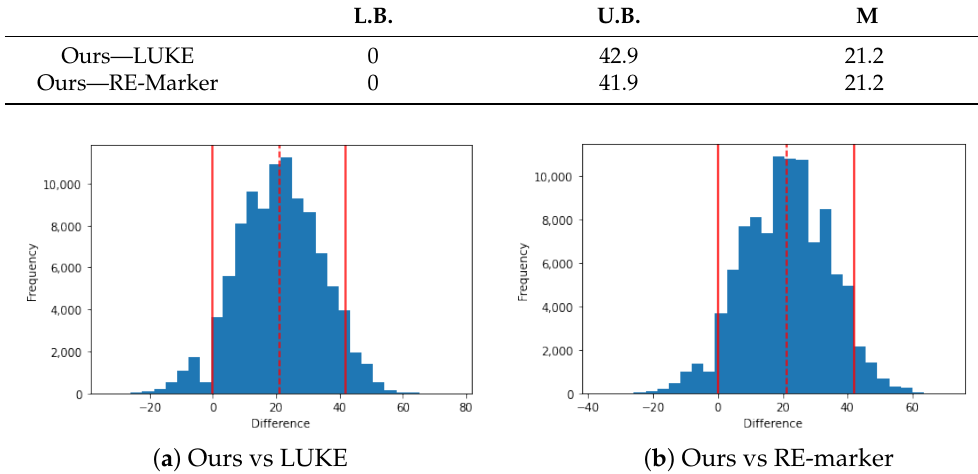
Table 6. 90% confidence interval of the differences between MC F1 scores of models. L.B., U.B. and M denotes the lower bound, upper bound and median value, respectively.